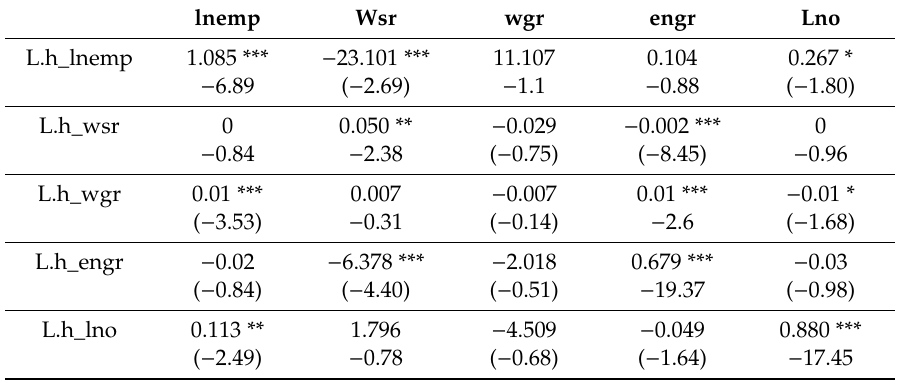
Table 5. Panel vector autoregressive model (PVAR) estimation results of clean industries. lnemp Wsr wgr engr